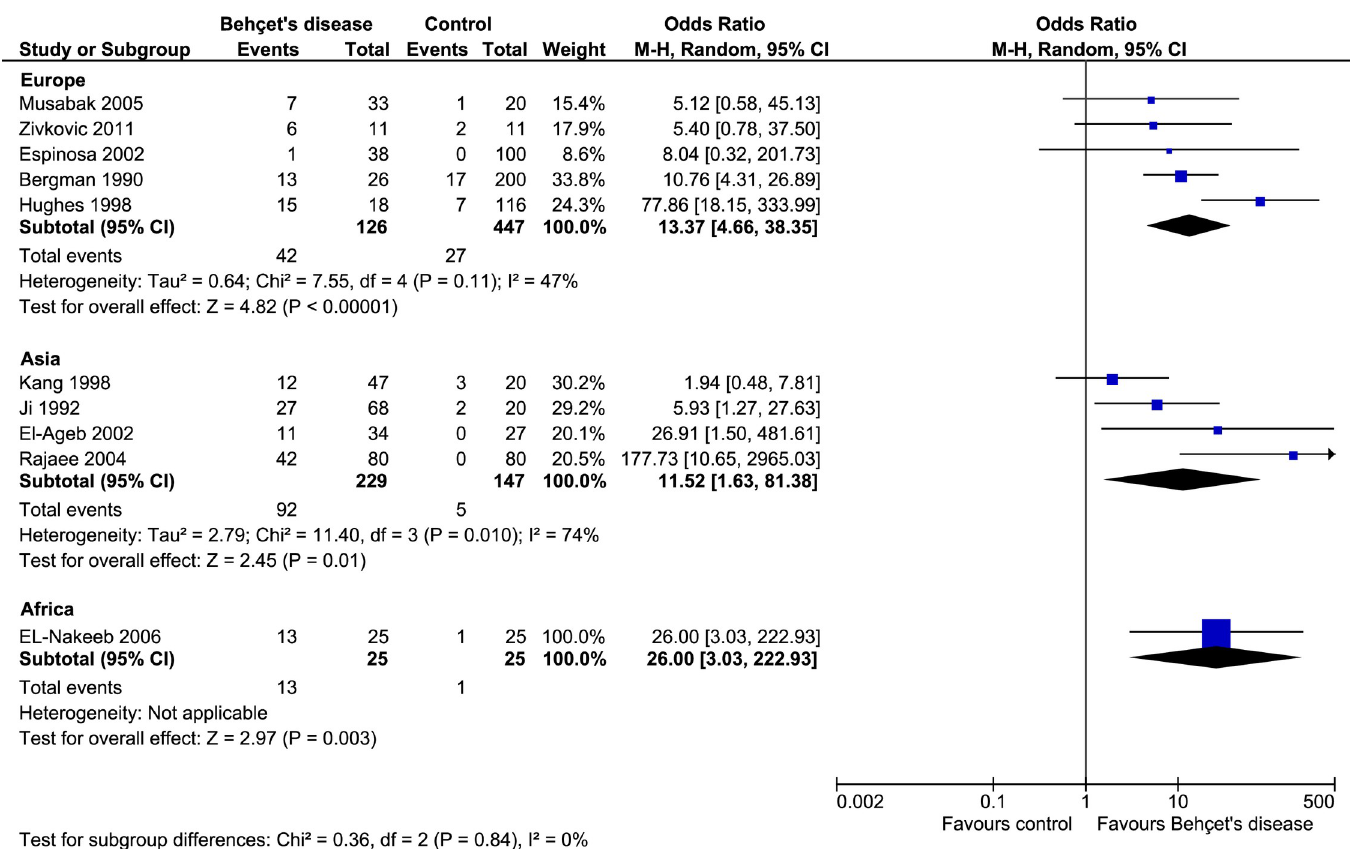
Fig 3. Subgroup analysis on the prevalence of aCL antibodies in European, Asian and African patients with Behc¸et’s